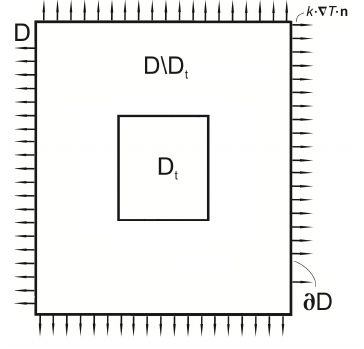
Figure 3. Controlled tissue